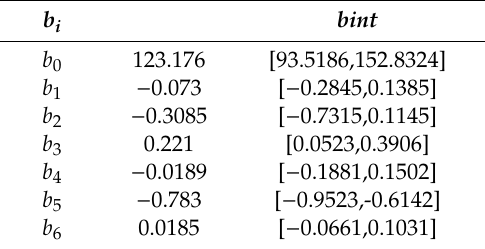
Table 5. Regression coefficient Interval.